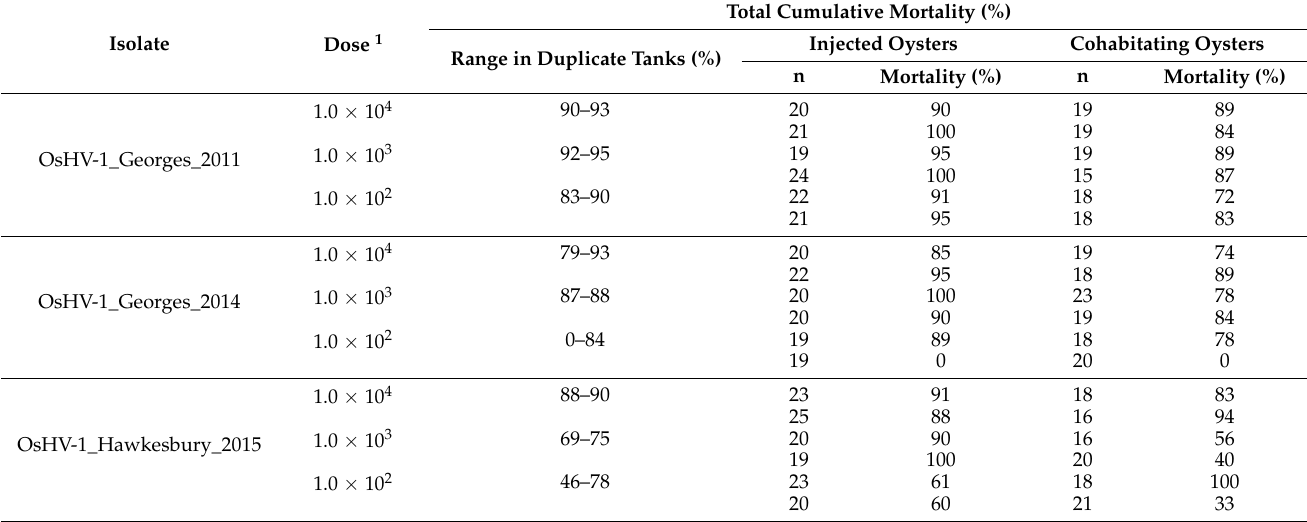
1 OsHV-1 DNA copies/injected oyster.